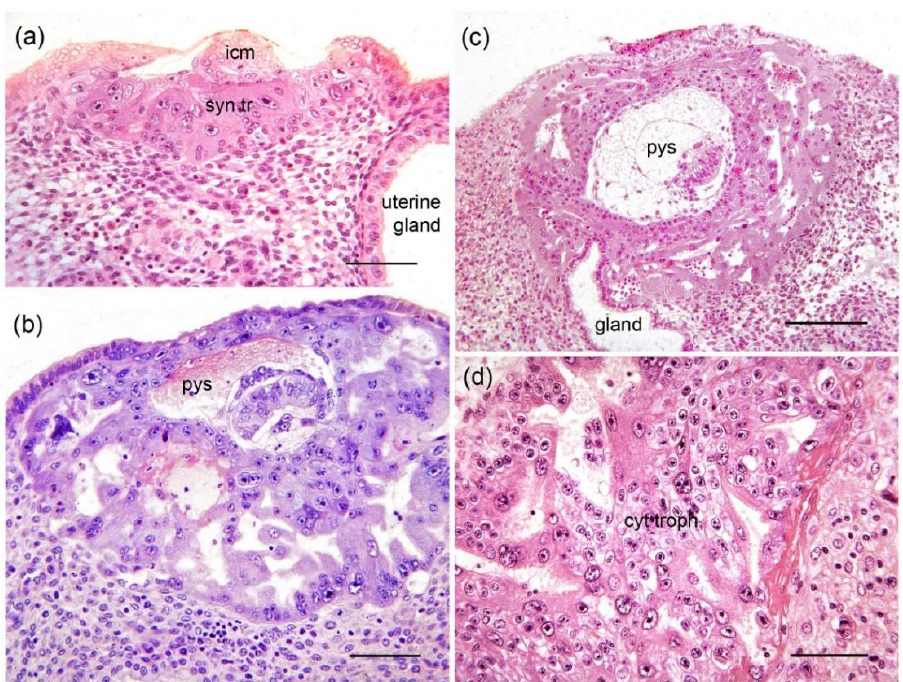
Figure 3. Early differentiation of mesoderm in the human embryo. ( a ) Trophoblastic plate stage (Carnegie Stage 5a) showing the inner cell mass (icm). The cavity of the blastocyst is collapsed. The pad of trophoblast has different sized nuclei and both cellular and syncytial trophoblast (syn tr) (Carnegie Embryo #8020). Scale bar, 70 µm. ( b ) Early lacunar stage (Carnegie Stage 5b) Some maternal blood has leaked into the primary yolk sac (pys). Note the irregular shape of the lacunae on the right, which appear to be formed from expanding clefts (Carnegie Embryo #8004). Scale bar, 90 µm. ( c ) Lacunar stage (Carnegie Stage 5c). Note the anastomotic lacunae within the syncytiotrophoblast. In the area between the trophoblast and the already partially constricted primary yolk sac (pys), there are mesenchymal cells (extraembryonic mesoderm) (Carnegie Embryo #7699). Scale bar, 176 µm. ( d ) Predecessors of the primary villi (Carnegie Stage 6). The cytotrophoblast (cyt troph) is accumulating in the partitions between lacunae, initiating the formation of primary villi (Carnegie Embryo #9260). Scale bar = 70 µm. Reprinted with permission from Carter, Enders and Pijnenborg [16] © The Authors. Published by the Royal Society. All rights reserved.